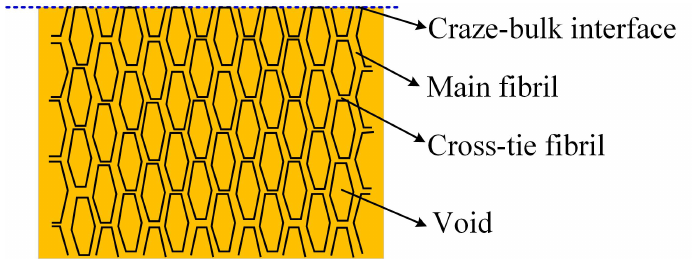
Figure 4. Schematic illustration of the craze structure.